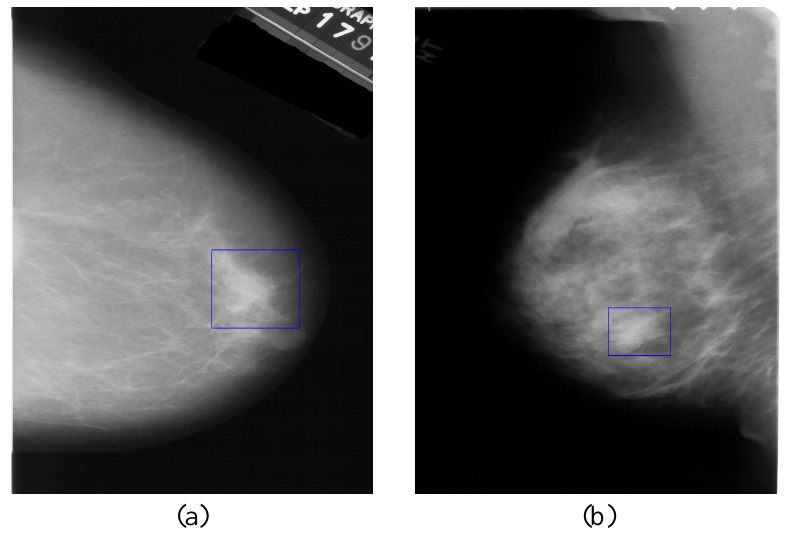
Figure 1. Molybdenum target mammograms. The regions of blue rectangles in ( a , b ) are breast